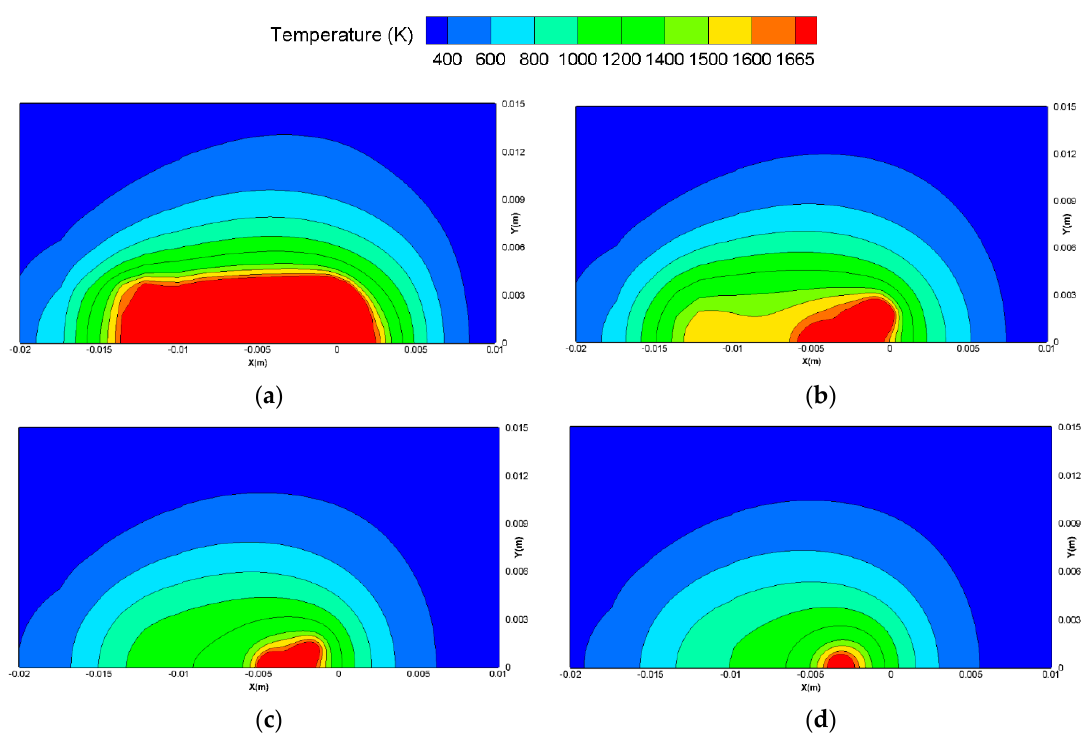
Figure 9. Weld pool and temperature field on the longitudinal sections ( t = 3.2 s). ( a ) z = 6 mm; ( b ) z = 4 mm; ( c ) z = 2 mm; ( d ) z = 0 mm.